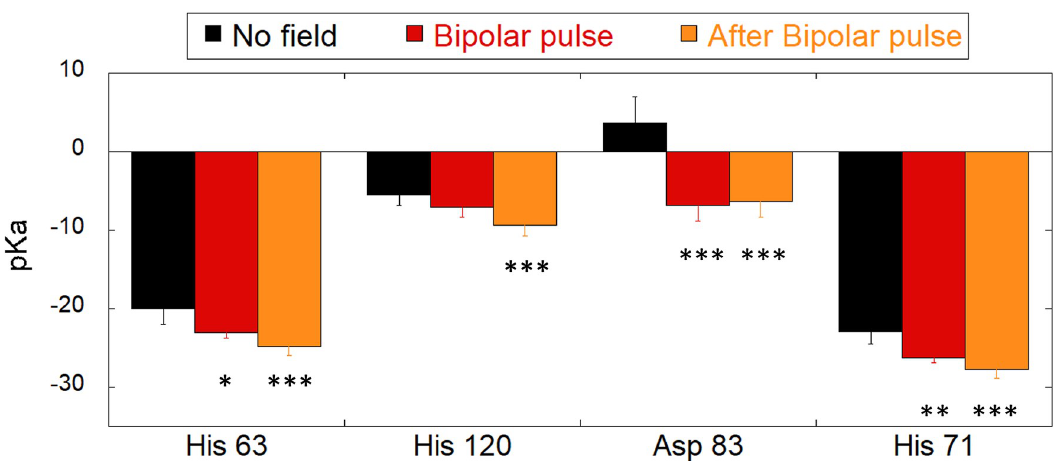
Fig 8. pKa values shifts of four specific protein residues. pKa values of His 63, His 120, Asp 83 and His 71 calculated before BP application (black hystograms), during the negative pole of the BP and after BP removal. Student-t test has been applied to verify the statistical significance of pKa negative shifts in presence and after the BP